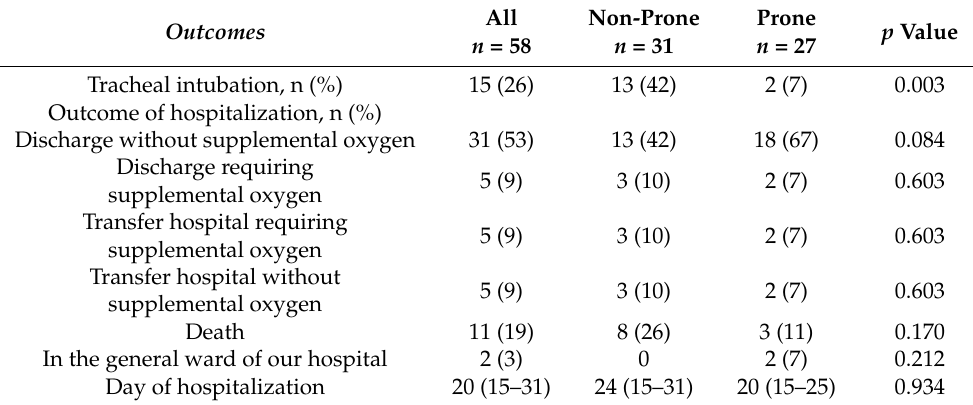
Table 3. Clinical outcomes according to prone positioning.